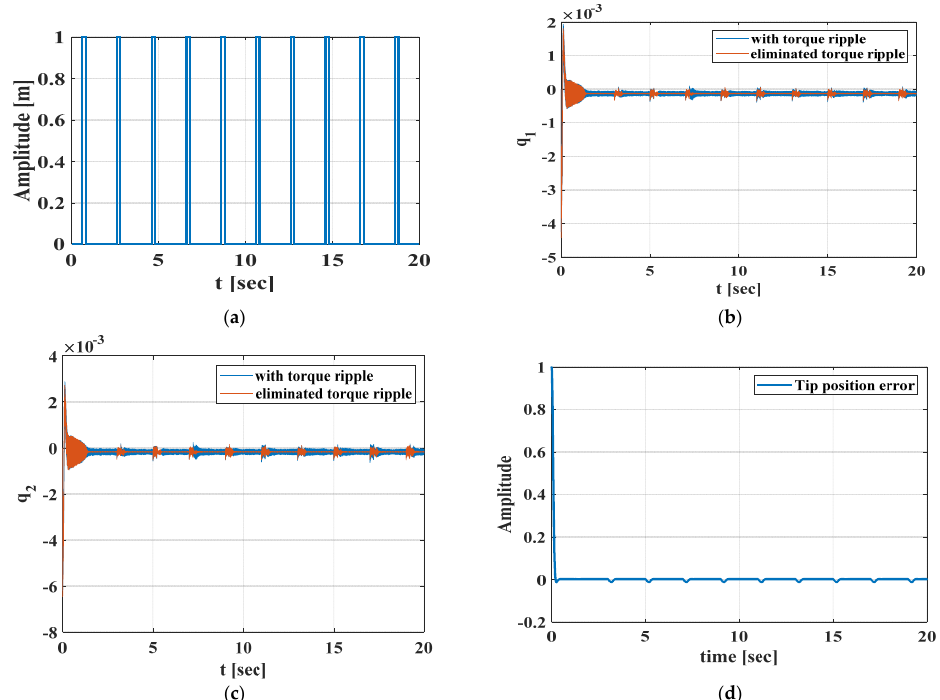
Figure 4. Disturbance on the flexible robot arm, which is reflected as the displacement of the moving mass ( a ). Set-point ( b , c ) and tracking ( d ) control performance of the SMC-based adaptive linearizing control scheme concerning the step type endpoint reference (the units are in meters).